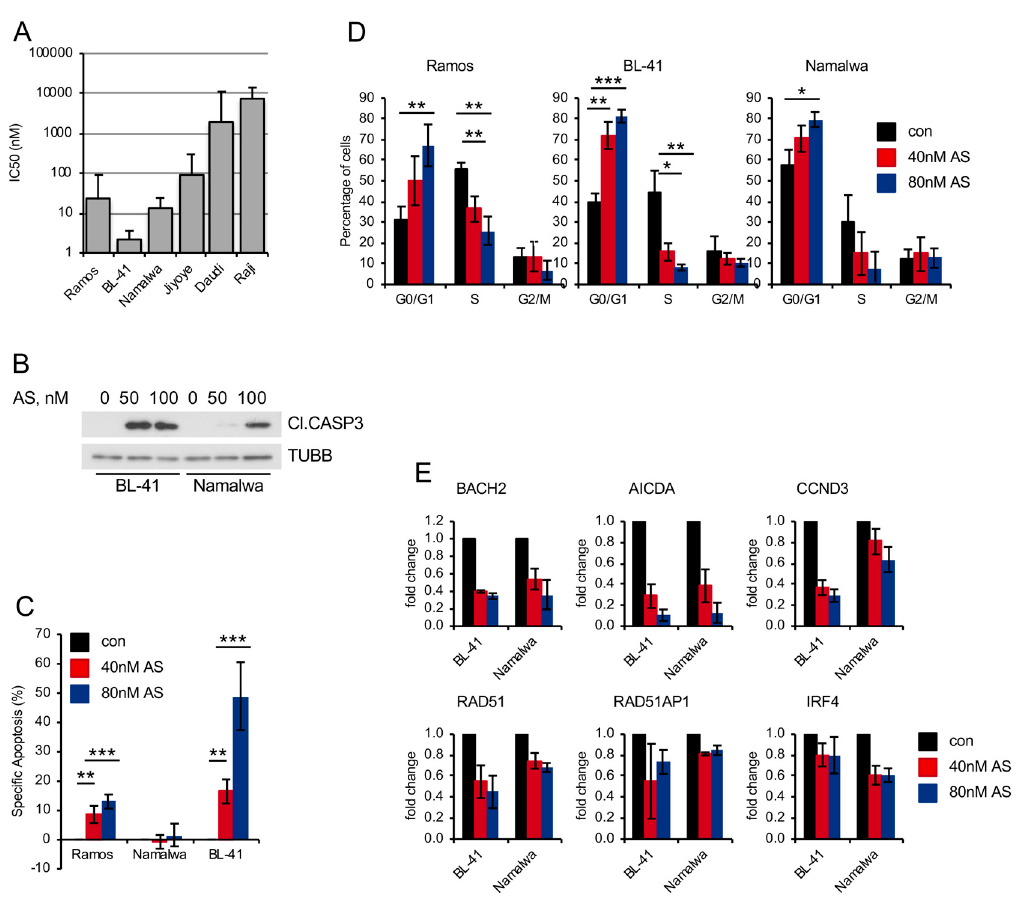
Figure 4. AS1842856 treatment is toxic for BL cell lines. ( A ) Sensitivities of BL cell lines to FOXO1 inhibitor AS1842856 (AS). Cells were exposed to increasing concentrations of AS for 5 days. Cell viability was assessed using MTT assay and IC50 values were calculated using GraphPad Prism software. Data are shown as mean ± SD ( n = 3). ( B ) Cleaved CASP3 was detected in BL cell lines treated with AS or DMSO for 4 days using immunoblot. TUBB served as loading control. A representative of 3 independent experiments is shown. ( C ) AS induces apoptosis in BL cell lines. Cells were treated for 4 days with AS or DMSO, followed AnnexinV-FITC / PI staining. Data are shown as mean of specific apoptosis ± SD ( n = 2). The data were analyzed by two-sided T-test. **, p < 0.01, ***, p < 0.001. ( D ) AS inhibits cell cycle progression. Cells were incubated in the presence of AS or DMSO for 4 days, followed by fixation and PI staining. After FACS measurement percentage of cells in di ff erent cell cycle phases was assessed and is shown as mean ± SD ( n = 3). The data were analyzed by two-sided T-test. *, p < 0.05, **, p < 0.01, ***, p < 0.001. ( E ) Downregulation of FOXO1 target genes after treatment with AS compared to DMSO-treated cells. Treated cells were harvested after 24 h and RNA expression levels were analyzed by qRT-PCR. qRT-PCR data were quantified by the 2 − ∆∆ CT method. Data are shown as mean ± SD ( n = 3). The data were analyzed by two-sided T-test. For all genes and cell lines p < 0.05 with exception of Namalwa + 40 nM AS CCND3 p = 0.051; BL-41 + 40 nM AS RAD51AP1 p = 0.136.